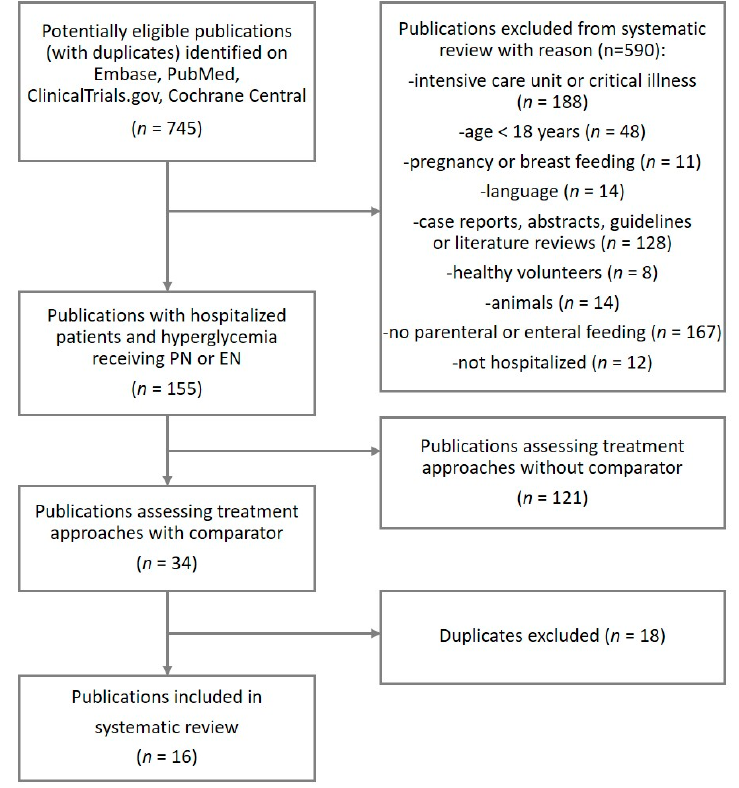
Figure 2. Flowchart illustrating the study selection process.